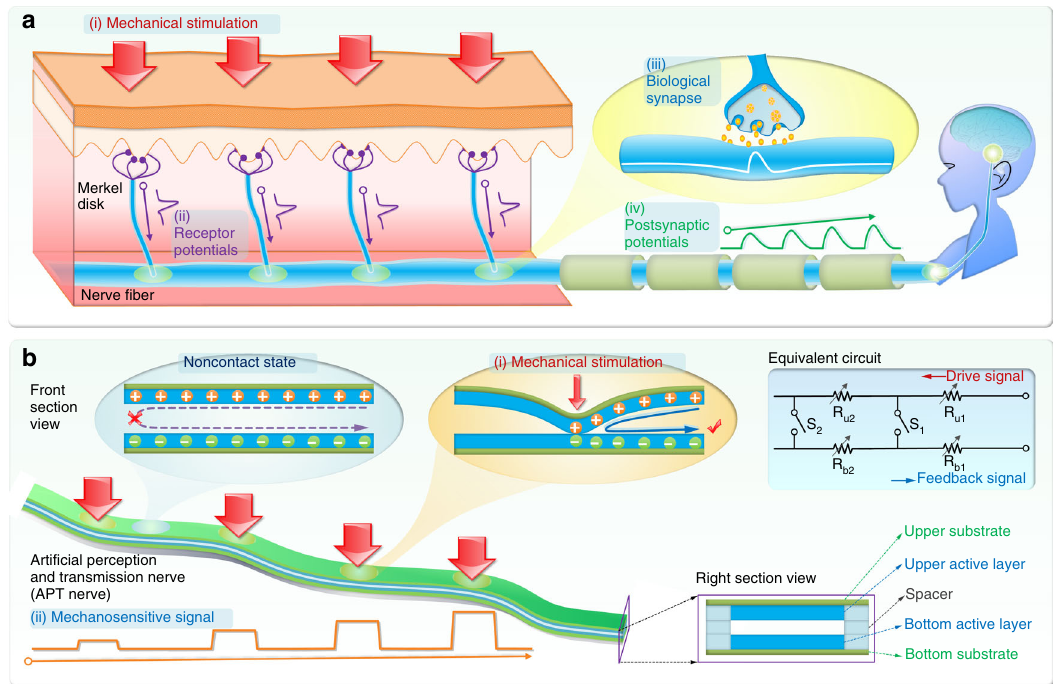
Fig. 1 Biological sensory neurons and an arti fi cial perception and transmission nerve. a Schematic of the function of biological sensory neurons. Mechanical stimulations are converted into receptor potentials by mechanoreceptors. The receptor potentials induce postsynaptic potentials by synapses. Postsynaptic potentials are transmitted to the cortex for information processing through the interneurons. b Architecture and working mechanism of an arti fi cial perception and transmission nerve (APT nerve). Mechanical stimulation applied on the APT nerve is directly converted into mechanosensitive signals for information processing. Top left: Working mechanism of the APT nerve. Top right: Equivalent circuit. Bottom right: Structure of the APT nerve in right section